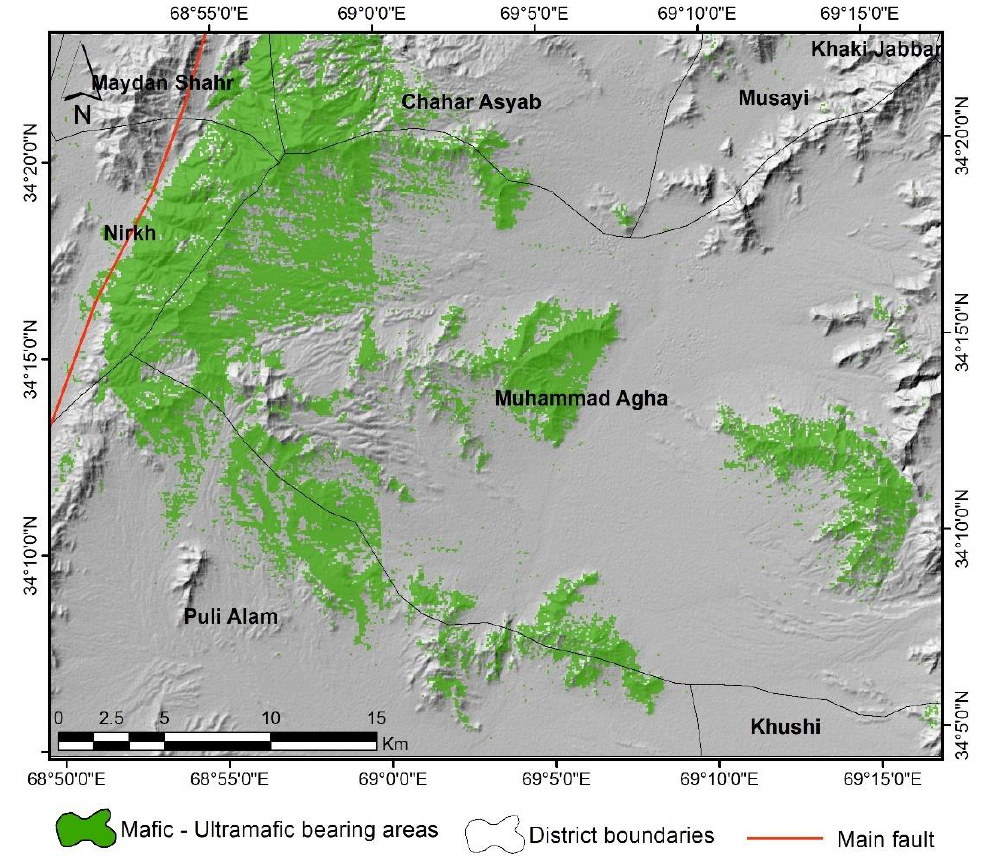
Figure 6. The spatial distribution of mafic–ultramafic rocks (ophiolites) over the Logar Ophiolite Complex generated by the refined version of MI added to the shaded relief map.